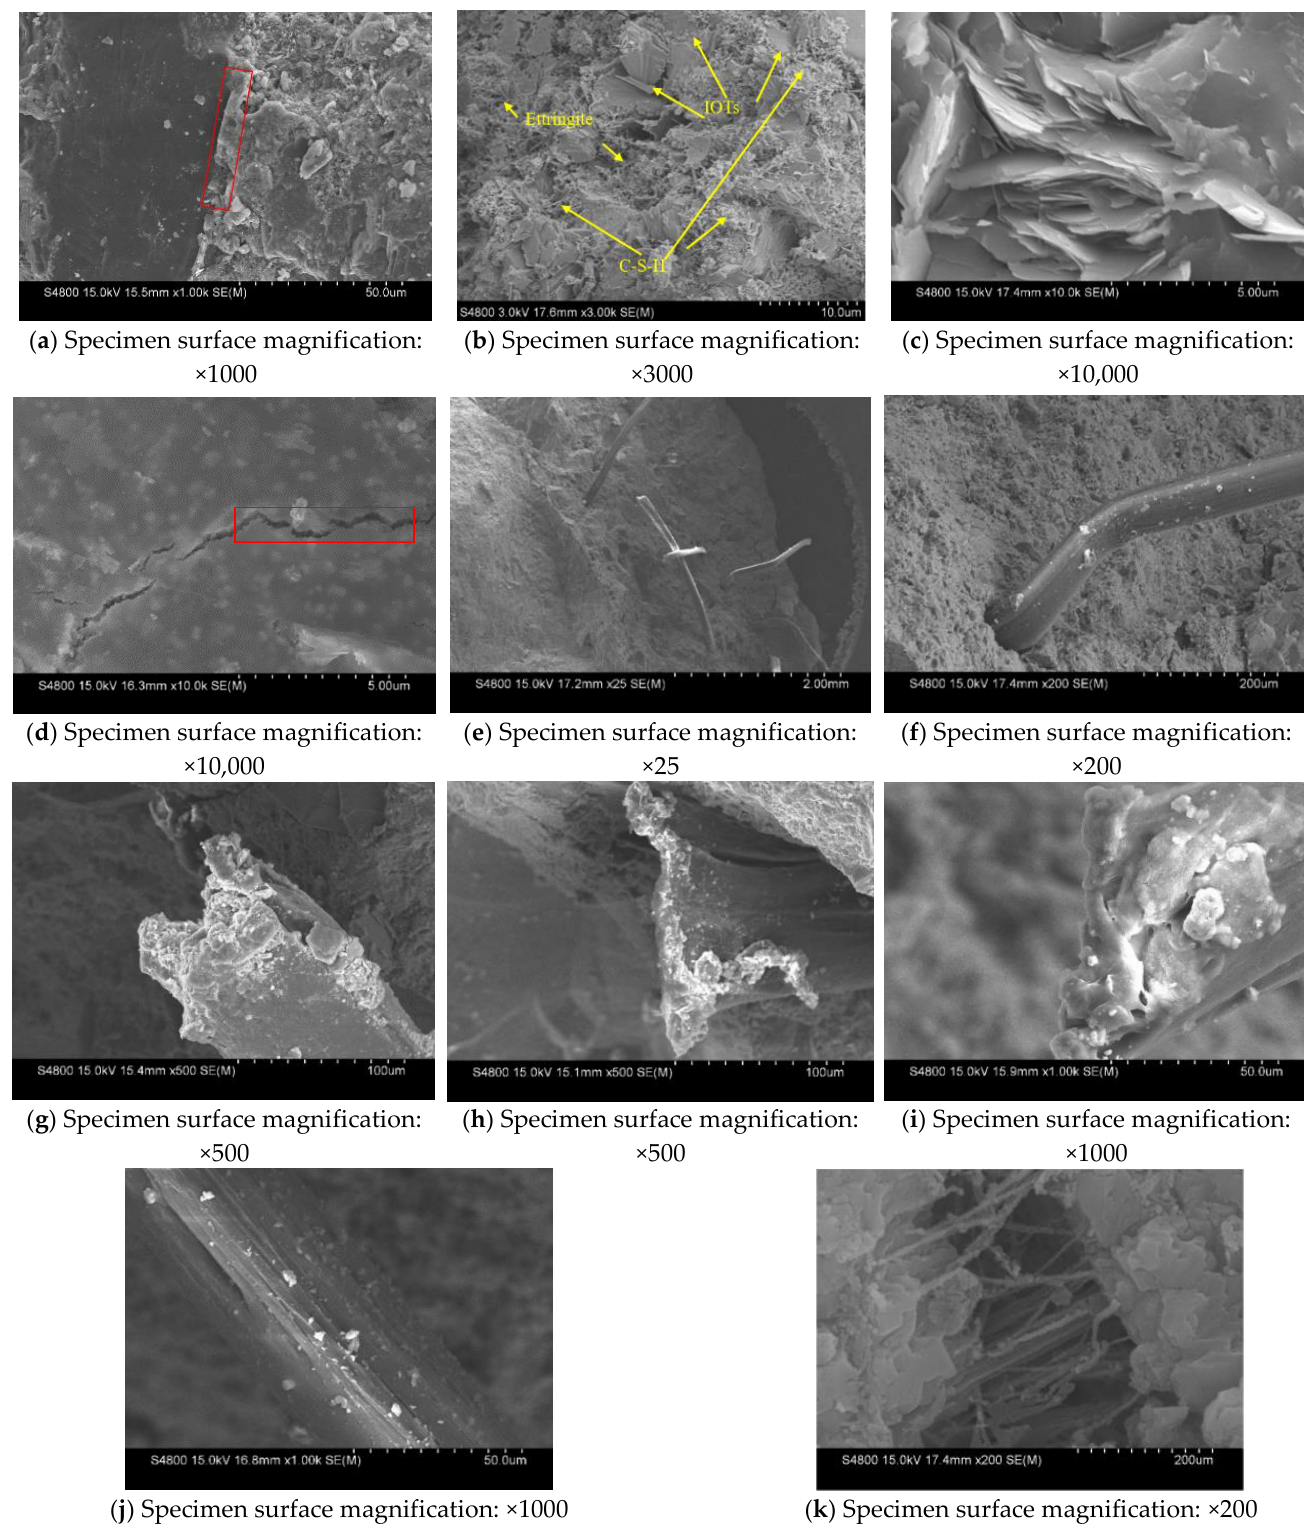
Figure 9. Microstructure of TRAC ( a – d ) and TRAC-PP0.6 ( e – k ). Figure 9a – d show the SEM images of the specimen TRAC. The morphology of the interfacial transition zone (ITZ) between IOTs and the surrounding matrix is presented in Figure 9a, and the bonding appeared very dense. In Figure 9b, we observed a large amount of calcium silicate hydrate (C-S-H) gel, needle-like crystals (ettringite), and IOTs. IOTs had a certain pozzolanic activity and can react with calcium hydroxide to form C-S- H gel, which made the microstructure of the concrete denser, improving the strength of RAC [33,38]. This result was consistent with that of our previous study that showed that IOTs improved the compressive strength of RAC [13]. Similar results have been reported by Duan et al. [39 – 41]. From Figure 9c, it can be seen that there were a large number of monosulfate calcium sulfoaluminate hydrates (AFm) with rose-like blossom shapes in the ITZ region of IOTs. When gypsum was insufficient, needle-like ettringite transformed to AFm, which had a positive effect on the specimen strength. Additionally, a small number of cracks with a wi dth of approximately 0.2 μm were observed on the surface of IOT particles (Figure 9d). The higher the IOT content, the more the cracks in aggregates, resulting in reduced mechanical properties of concrete. There- fore, the content of IOTs needed to be strictly controlled to avoid the loss of mechanical